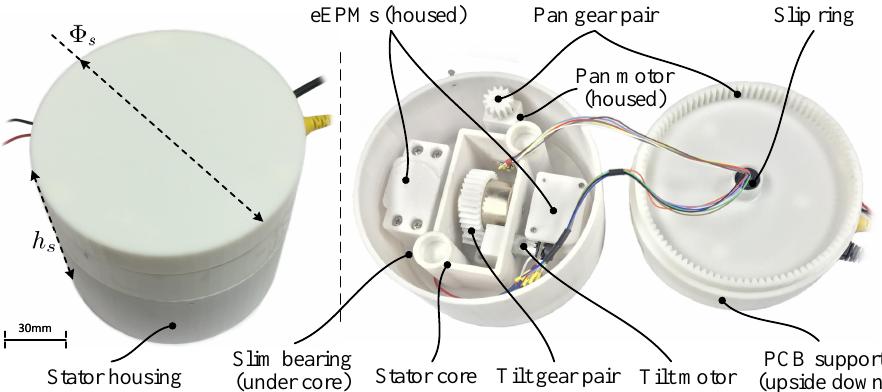
Figure 5. Mechanical design and fabrication of the stator: the assembled stator profile ( left ) and its inside mechanism ( right